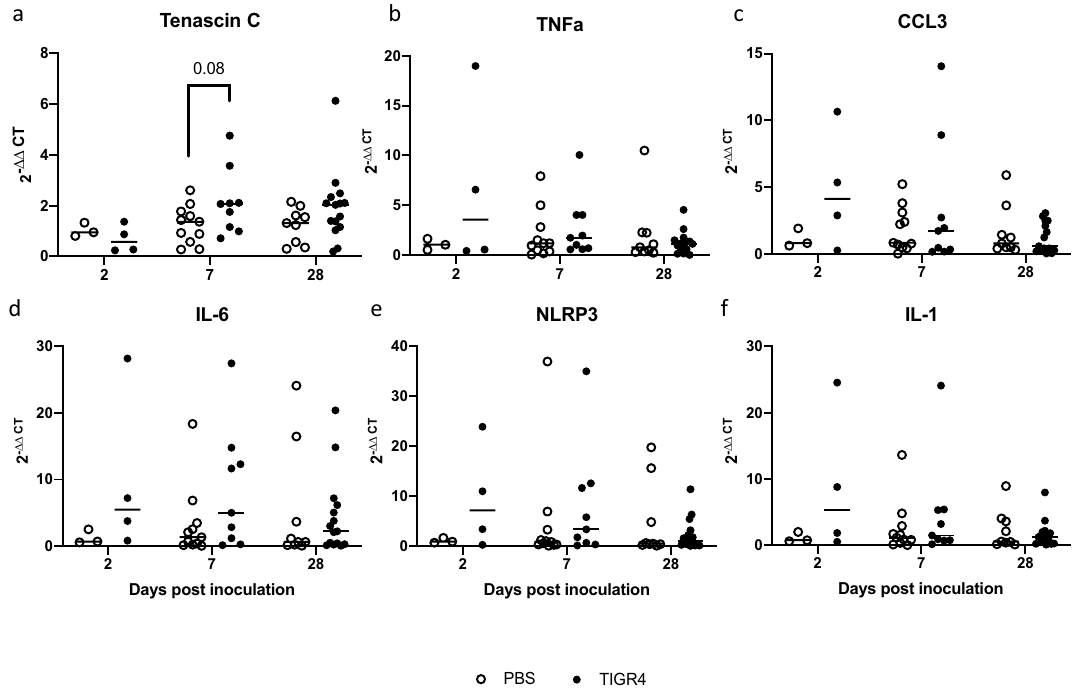
Figure 5. Gene expression of inflammatory mediators in the heart apex. Tissues from TIGR4- and PBS- inoculated mice were collected at 2-, 7- or 28-days post-inoculation and mRNA expression levels of ( a ) tenascin C; at 7 days post-inoculation, there was a trend for increased levels of tenascin C ( b ) tumor necrosis factor- alpha (TNF-a), ( c ) chemokine (C-C motif) ligand 3 (CCL3), ( d ) interleukin-6, ( e ) NLR family pyrin domain containing 3 (NLRP3) and ( f ) interleukin-1 were quantified by real-time polymerase chain reaction. Target gene was normalized against the housekeeping gene, HPRT. Solid horizontal line represents the